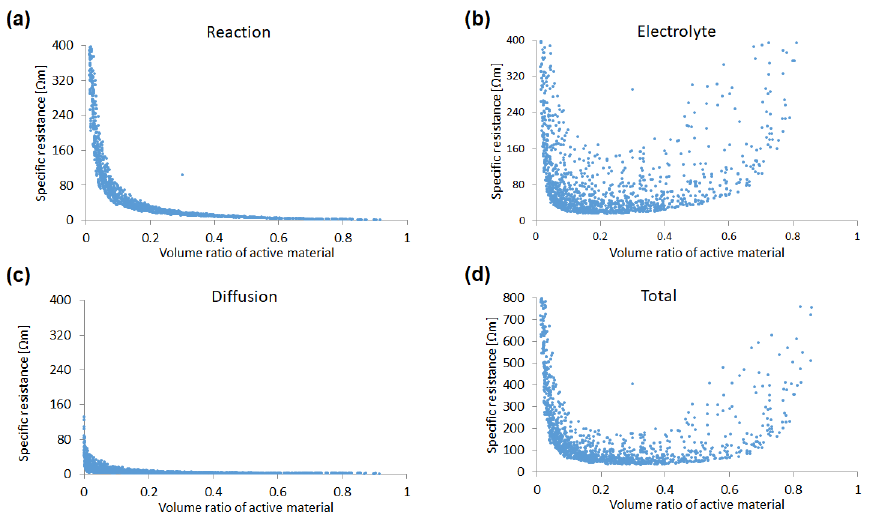
Figure 3. Sensitivities of ( a ) reaction resistance, ( b ) electrolyte resistance, ( c ) Li diffusion resistance,